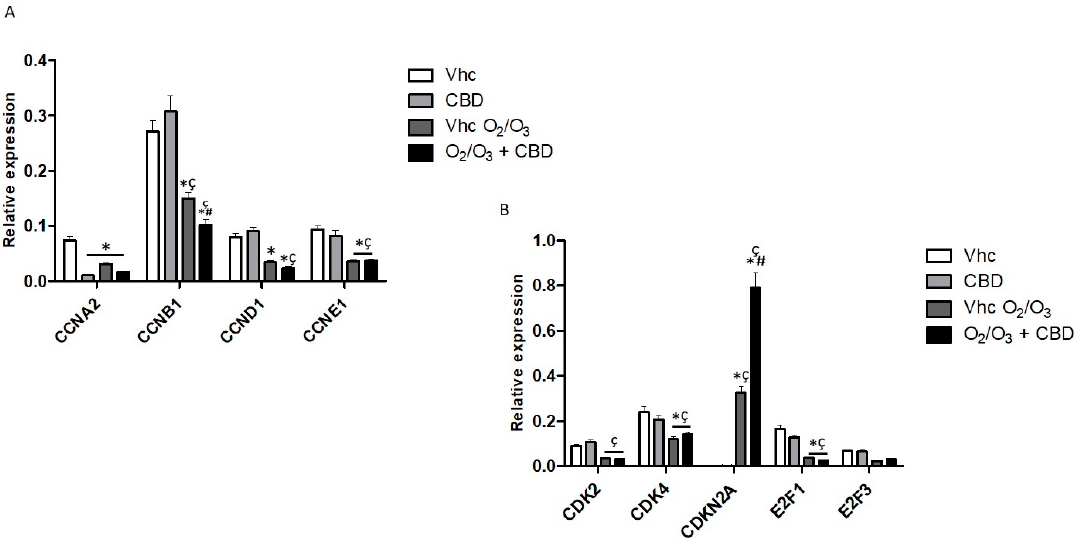
Figure 10. Modulation of cell cycle pathways in PANC-1 cell line. ( A ) CCNA2 , CCNB1 , and CCND1 , CCNE1 mRNA expression and ( B ) CDK2 , CDK4 , CDKN2A , E2F1 , and E2F3 mRNA expression was evaluated by qRT-PCR in the PANC-1 cell line, treated with CBD in the presence and absence of O 2 / O 3 . Target mRNA levels were normalized for GAPDH expression. Data are expressed as fold mean ± SE. * p < 0.05 vs. Vhc, #, * p < 0.05 vs. Vhc O 2 / O 3 , ç p < 0.05 vs. CBD.